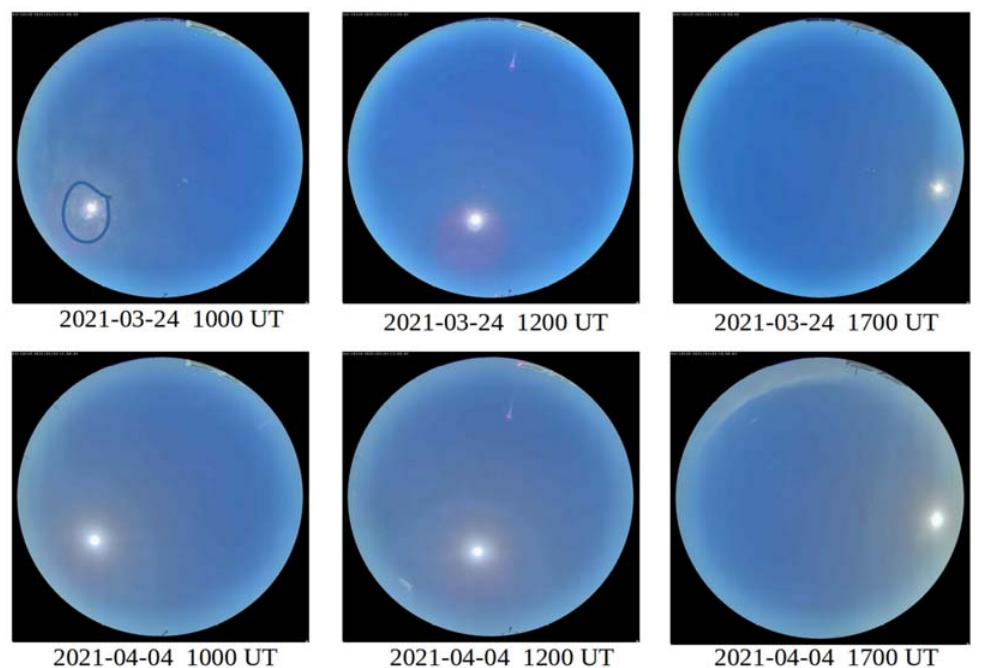
Figure 9. Sky pictures obtained with the all-sky imager at three instants during the two test days. A thin cloud (delimited by a blue line in the top left image) was in front of the sun at 1000 UT of the first